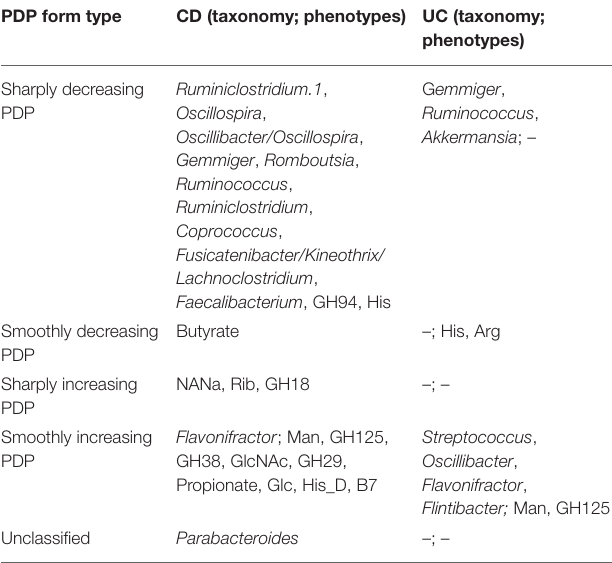
TABLE 4 | The forms of stable predictors PDPs (term “increasing” means increasing probability of the disease). PDP form